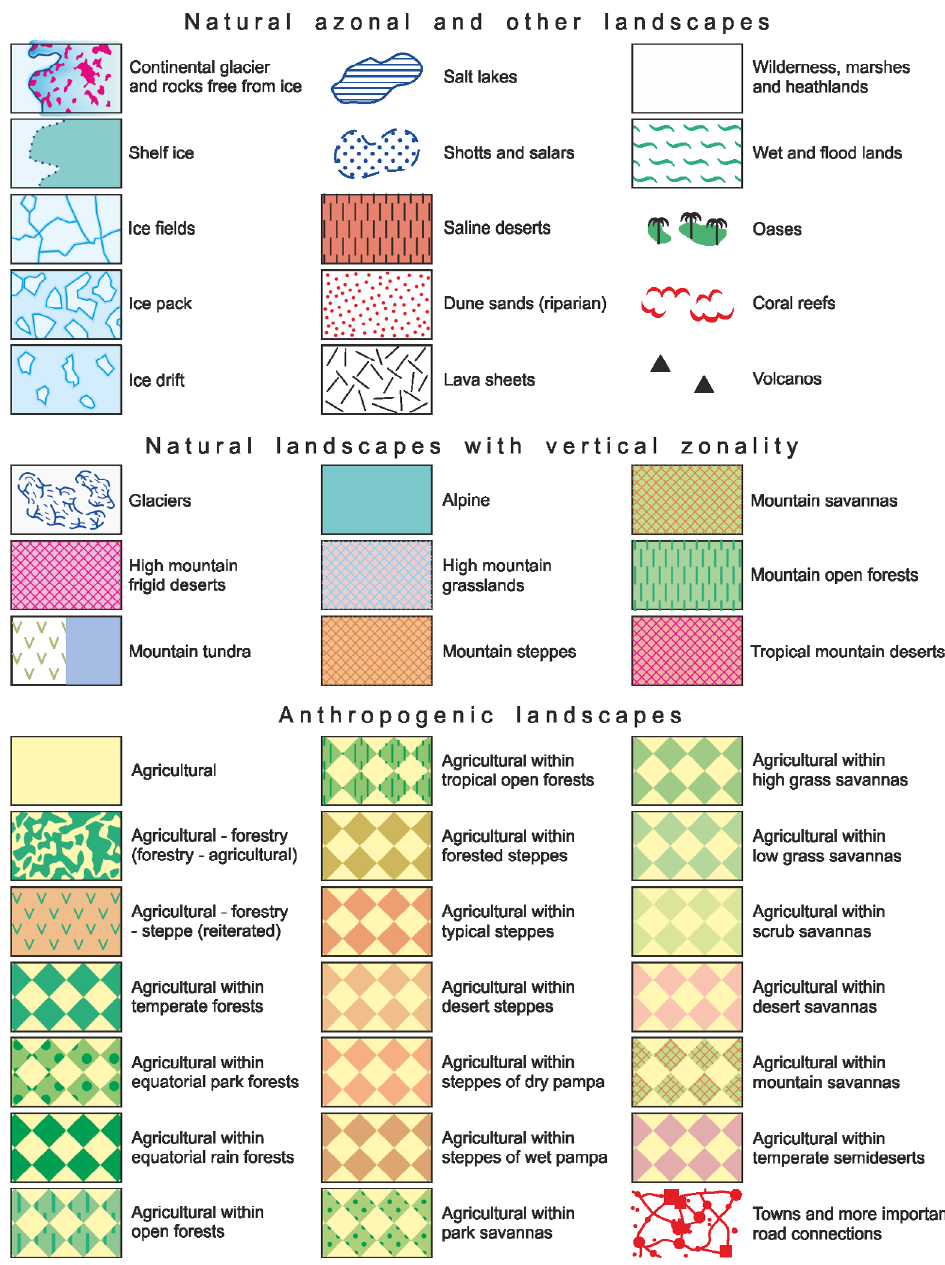
Fig. 3. List of cartographic symbols and paterns used by F. Uhorczak to present natural landscapes with vertical zonation, anthropogenic, azonal and others (the authors’